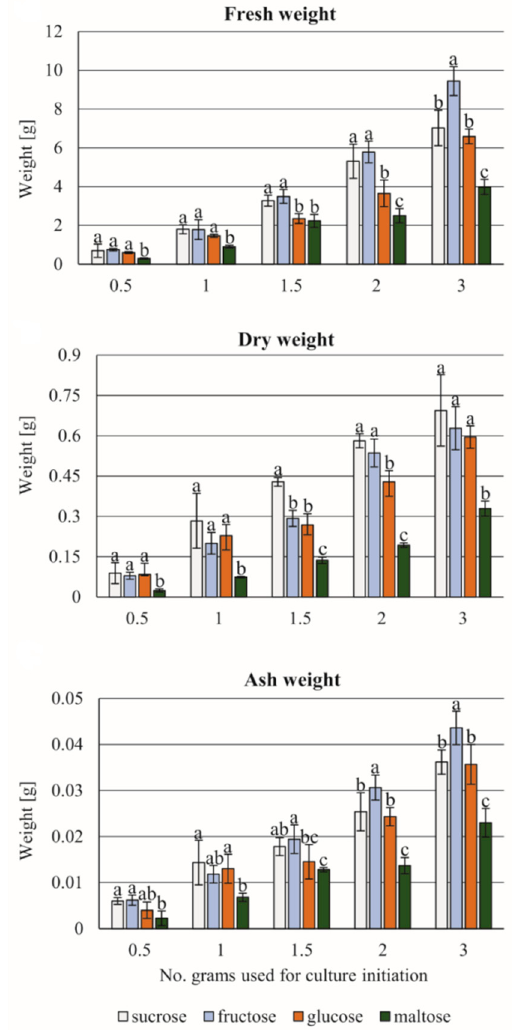
Figure 8. The dynamic growth of the cell suspension according to the initial weight of tissue and the saccharides supplementing the ½ MS medium with 9.05 µM 2,4-D + 0.88 µM BAP. Note: fructose has a significant effect on the dynamic of tissue growth. Means ± standard deviations marked by different letters are significantly different ( p ≤ 0.05).